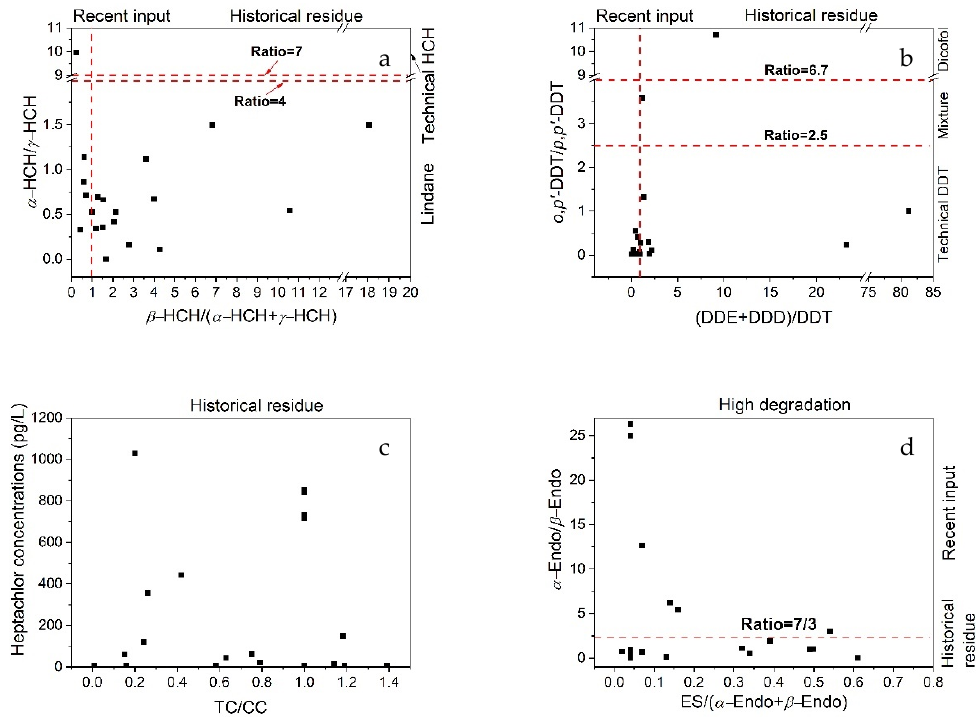
Figure 3. Ratios of HCHs ( a ), DDTs ( b ), chlordane ( c ) and endosulfan ( d ) in the Danshui